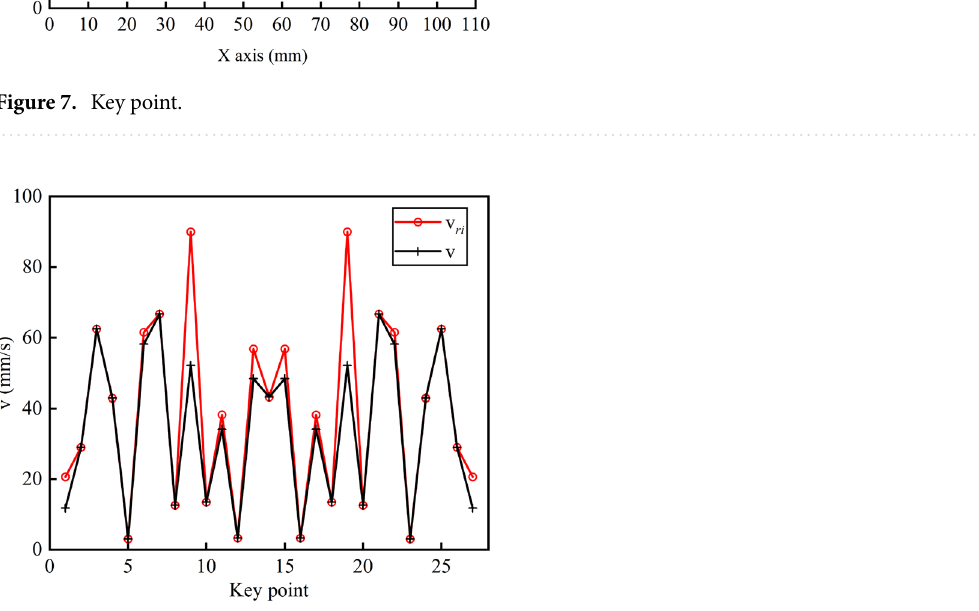
Figure 8. Key point speed